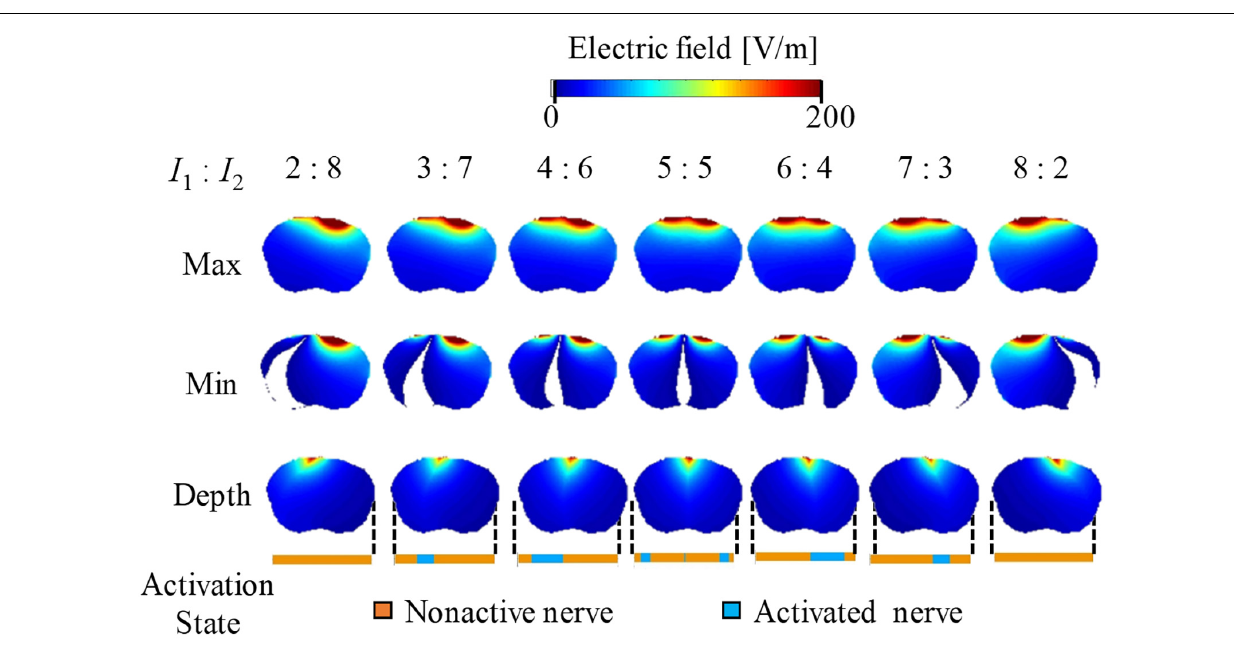
minimum value of the envelope (near zero) can be used to estimate the activated nerve region. In the case of depth, we envelope agreed with the center of the activated nerve